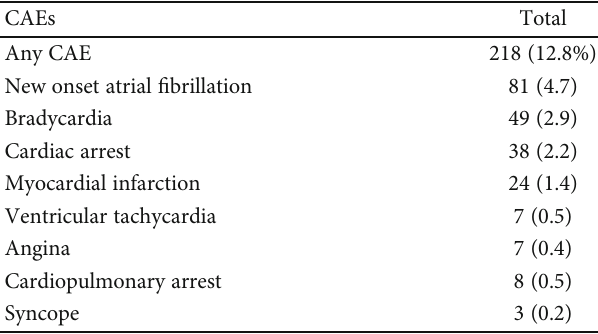
Table 3: Frequency of most common CAEs (including up to 3 CAEs per